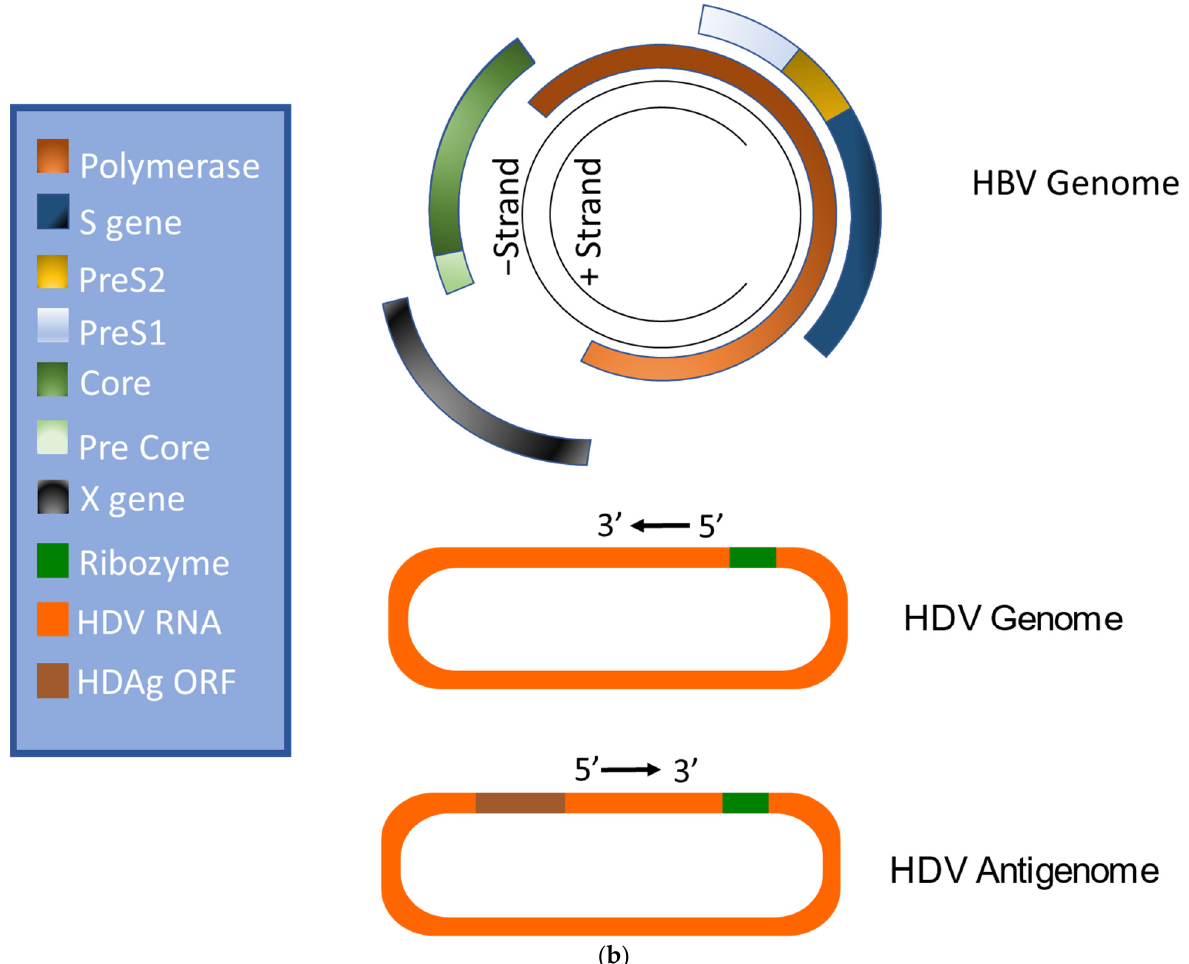
Figure 1. Virion and genome structures of hepatitis B virus (HBV) and hepatitis D virus (HDV). ( a ) Virion Structures of Hepatitis B Virus (HBV) and Hepatitis Delta Virus (HDV). Both HBV and HDV are enveloped in HBV surface proteins designated as small (S ‐ HBsAg), middle (M ‐ HBsAg), and large (L ‐ HBsAg). The HBV relaxed ‐ circular DNA (rcDNA) is partially double ‐ stranded, with a full minus strand and incomplete plus strand, and a surrounding icosahedral capsid comprised of the core antigen. HBeAg proteins are present between the envelope and capsid. The HDV virion contains a single ‐ stranded RNA genome that is complexed with small and large delta antigens (S ‐ HDAg and L ‐ HDAg, respectively). ( b ) Genomic Structure of HBV and HDV. HBV is a partially dsDNA virus composed of four distinct open reading frames (ORFs): polymerase, S, core, and X. There is significant overlap between the different ORFs. The RNA of both the single ‐ stranded RNA genome and the antigenome contain self ‐ cleaving ribozymes [53]. Unedited antigenome ultimately codes for S ‐ HDAg. The cellular enzyme adenosine deaminase acting on RNA 1 (ADAR1) ADAR1 can modify the antigenome to generate the genetic code for L ‐ HDAg [54].